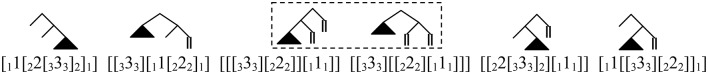
Binary-branching trees for remnant-movement-avoiding derivations of attested orders of three elements, with corresponding bracketing. The lexical root (e.g., N in a noun phrase) is shown as a black triangle, while structures with a terminal and trace of movement are represented with a double branch ||. The trees are represented this way to highlight the correspondence with the Dyck trees for these orders derived from stack-sorting.